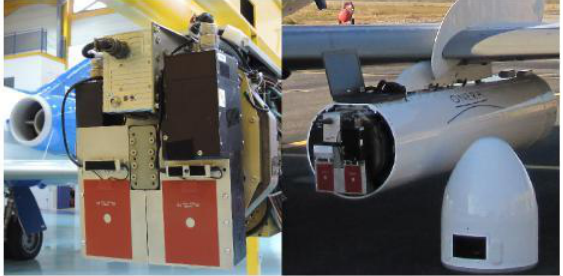
Figure 1 Camera VNIR1600 and SWIR256m-e inside the front part of the